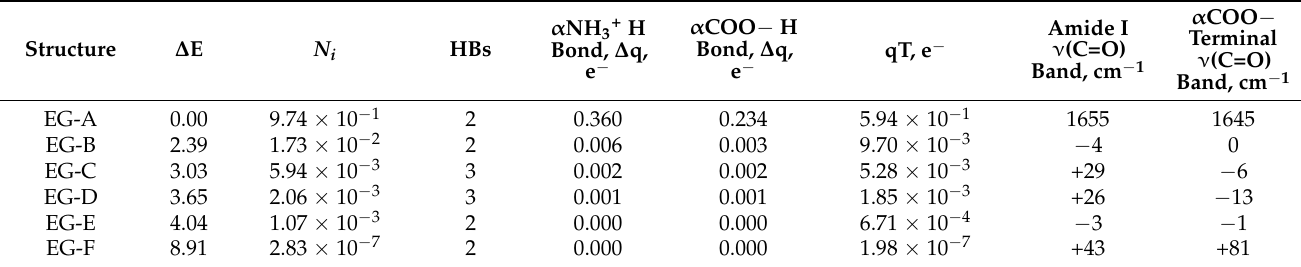
Figure 1. Lowest energy molecular geometries of the EG, ED, EA, EGE, EDE, DEA, EGED, EDEA, EGEDE, GEDEA, and EGEDEA peptide fragments, computed at the B3LYP/6-311++G(2 df ,2 pd ) level of theory. Intramolecular hydrogen bonds are represented by dashed yellow lines and the magnitudes are displayed for each, computed from natural bond order computations, presented in transferred electrons, e − . Table 1. Relative energies of the energetic minima for the EG, ED, EA, EGE, EDE, DEA, EGED, EDEA, EGEDE, GEDEA, and EGEDEA peptide fragments, computed at the B3LYP/6-311++G(2 df ,2 pd ) level of theory. The number of intramolecular hydrogen bonds (HBs); Boltzmann probability ( N i ); Boltzmann-weighted magnitudes of the hydrogen bonds, in e − ; Boltzmann-weighted total charge transferred into the system (qT); and the amide I and α COO − terminal ν (C=O) bands and shifts for each structure are also computed, in cm − 1